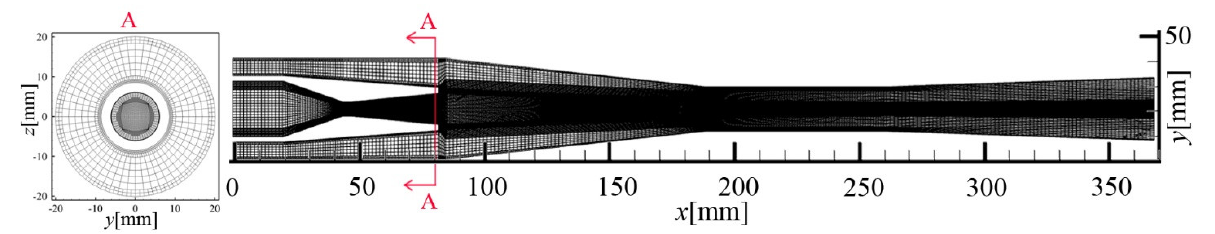
Figure 2. Schematic diagram of the 3D steam ejector mesh.